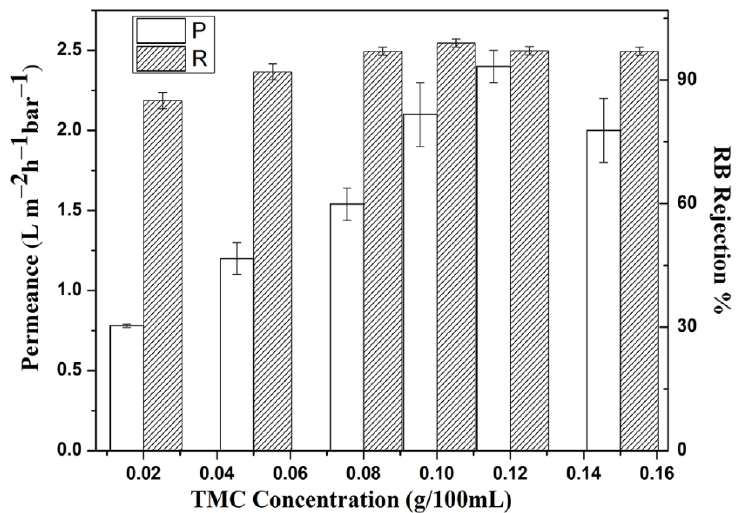
Figure 6. The effect of TMC concentration on the membrane performance in DMF.